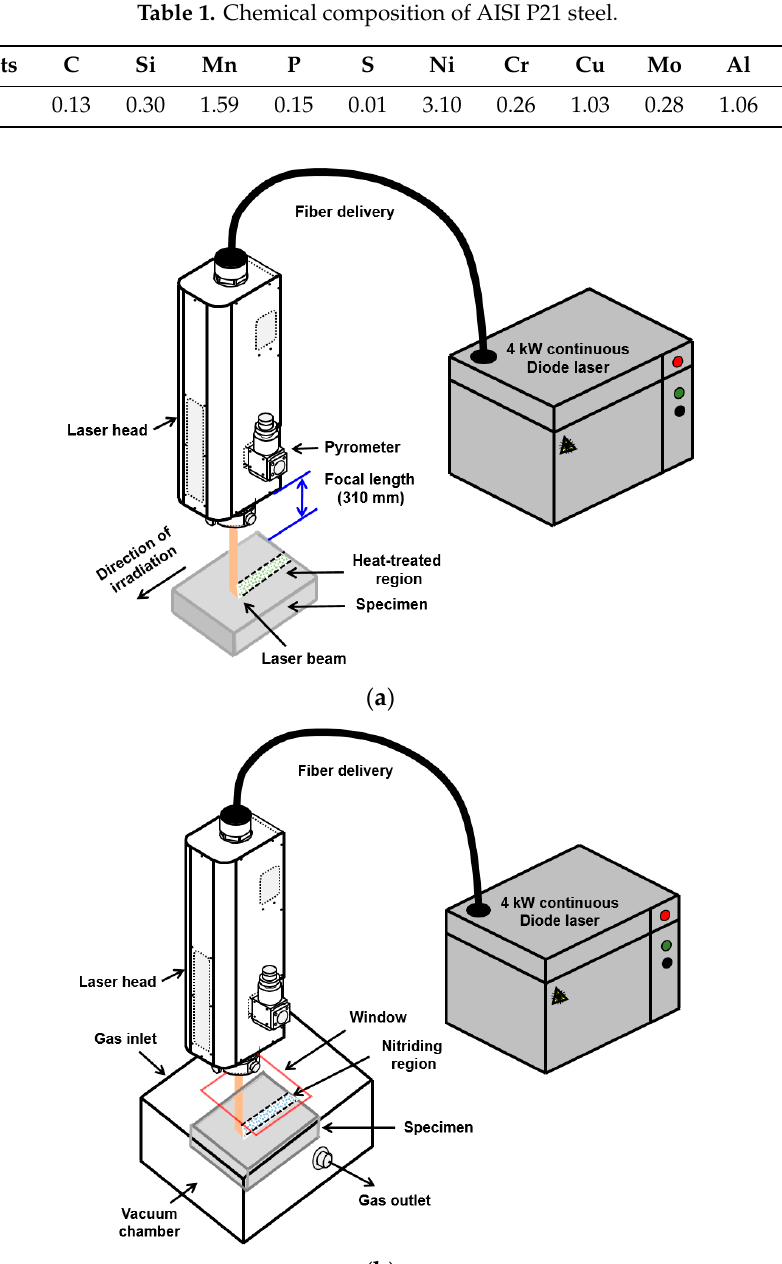
Figure 1. Experimental set-up for the ( a ) laser heat-treatment and ( b ) laser nitriding processes.